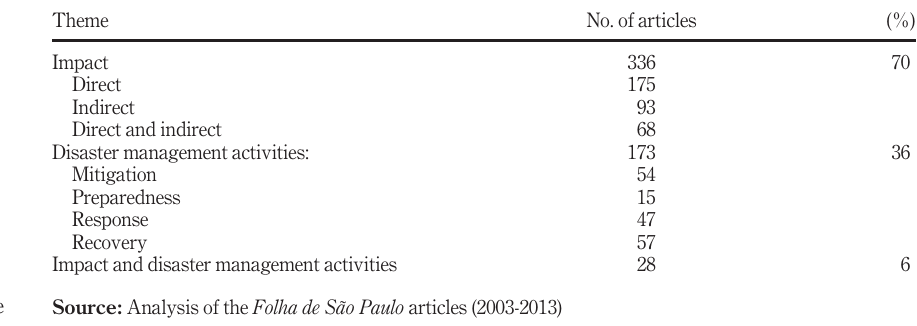
Figure 2. Total number of events of natural disasters in Brazil between 1991 and 2010*